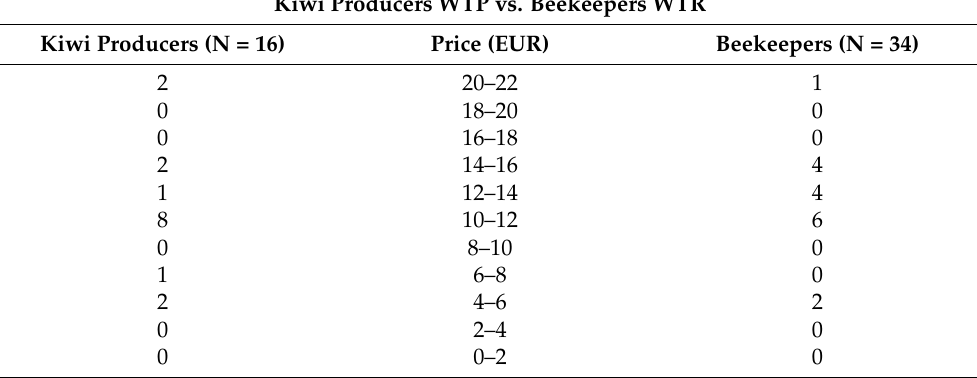
Table 4. Mann–Whitney U test across farmers and beekeepers’ current price in exchange for hives for pollination